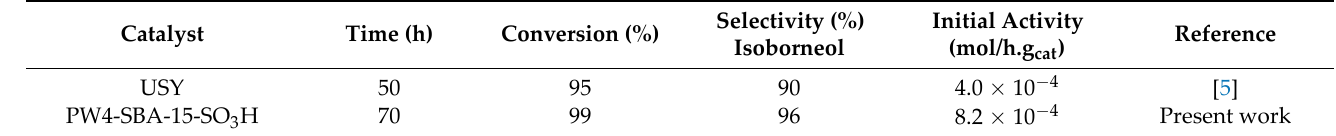
Table 3. Camphene hydration over heterogenous catalysts. Comparison of the results with literature